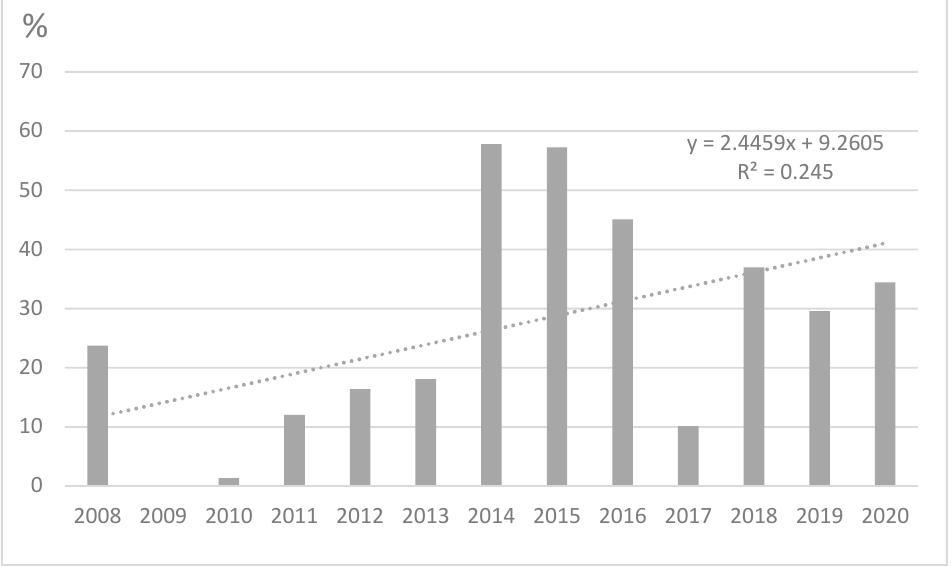
Figure 12. Annual volume of water measured in m 3 /day abstracted from the Drw ę ca surface intake and from the infiltration intake in Jedwabno within the period 2008–2020. The annual mean amount of water abstracted from the Drw ę ca River is characterized by a significant variation from 10,603.2 m 3 /d in 2017 to 24,203.8 m 3 /d in 2009 (Figure 12). The greatest annual water abstraction range occurred in 2008 and reached 31,594.7 m 3 /d. The groundwater abstraction level from the Jedwabno intake is considerably lower. The annual mean amount of water abstracted within the analyzed multiannual period ranged from 7767.9 m 3 /d in 2013 to 10061.5 m 3 /d in 2010. On average, within the analyzed period, 63.5% of all the water drawn comes from the Drw ę ca surface intake. In the period of the highest level of water abstraction in 2009, the water abstraction from the Drw ę ca surface intake constituted 73% of all water drawn.